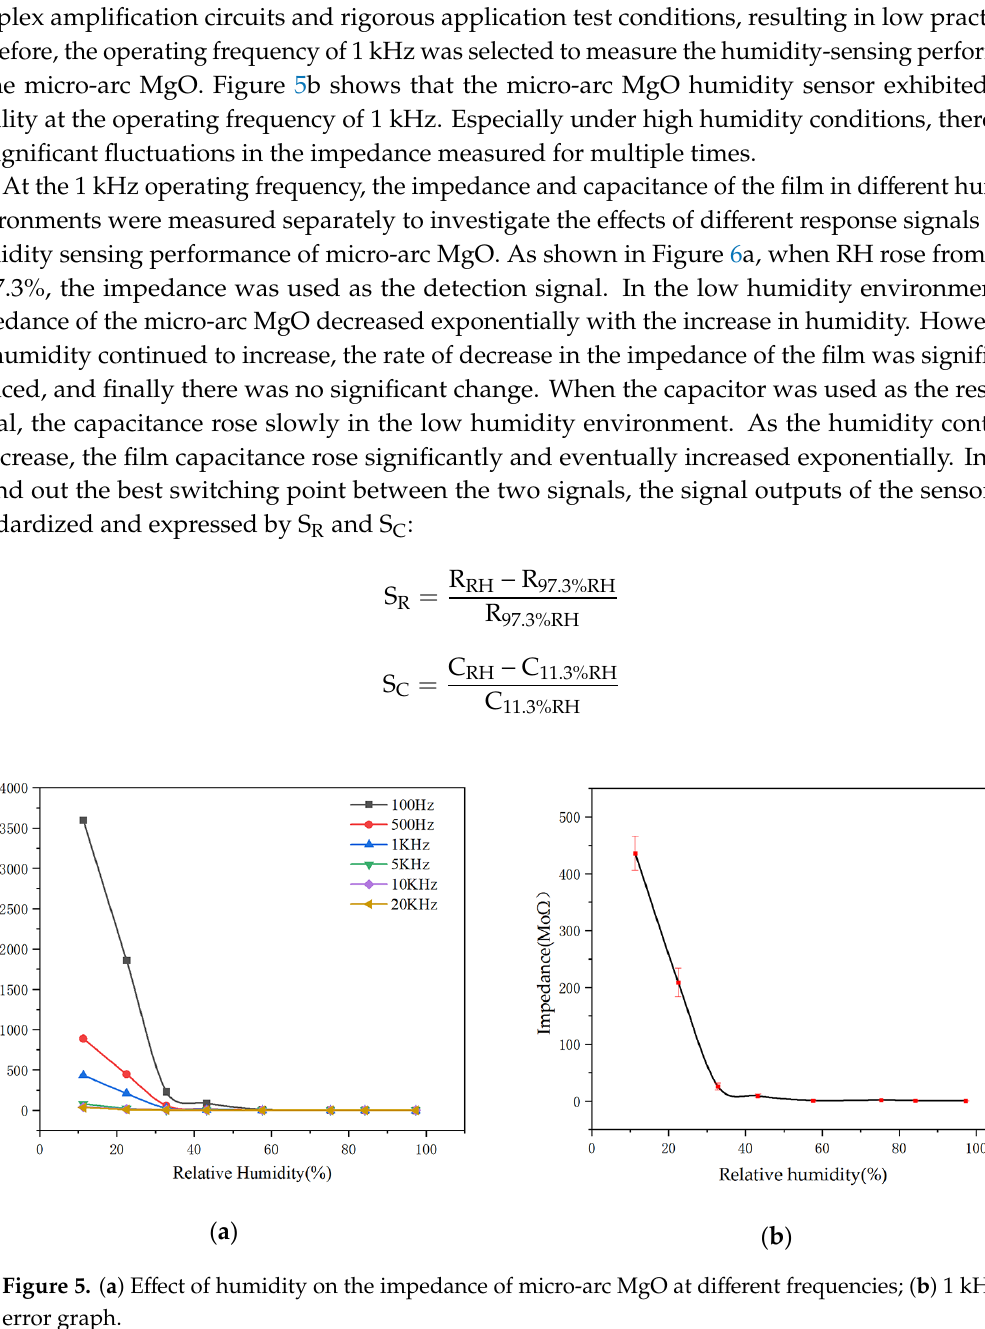
Figure 4 . XRD image of micro-arc MgO film.